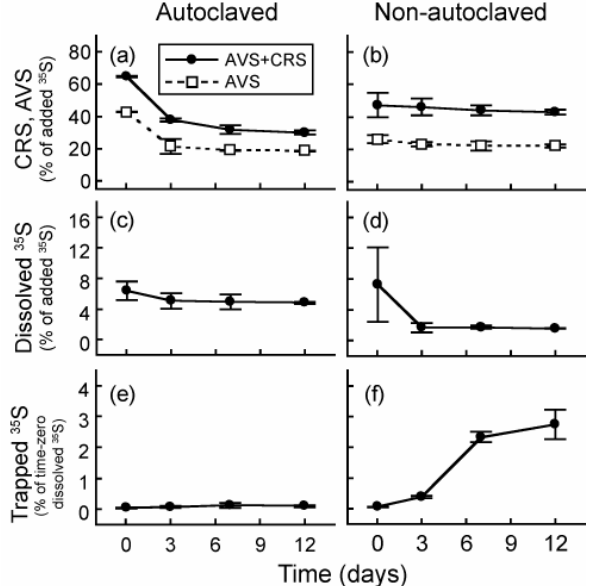
Fig. 4. Distribution of radioactivity in the sediment slurries of Lake Plußsee during incubation with H 2 , bicarbonate and H 35 zero values were measured two hours after addition of radiotracer. AVS: acid volatile sulfide (H 2 S + FeS); CRS: chromium reducible sulfur (S 0 + FeS 2 ) . The dissolved 35 S was measured from filtered slurry supernatant. The trapped 35 S was interpreted to represent labeled dimethyl sulfide. Error bars represent ± 1 standard error of duplicate